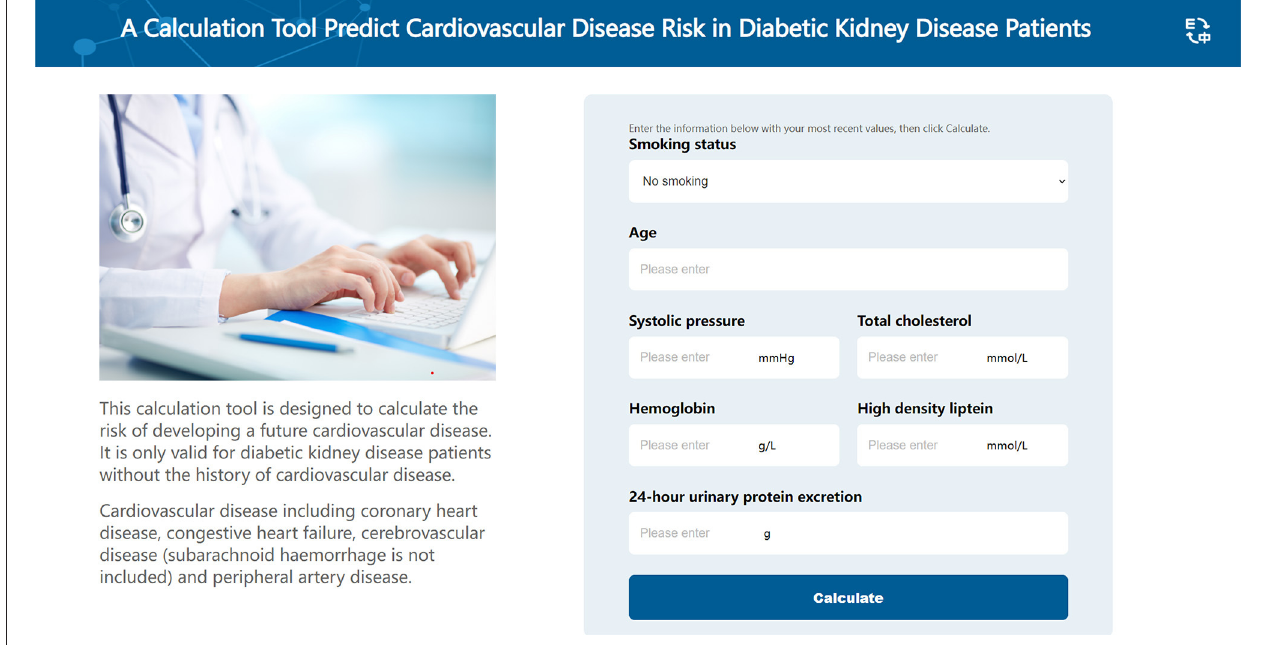
FIGURE 6 | The interface of the online calculation tool. This online calculation tool is used to predict the cardiovascular disease risk among diabetic kidney disease patients.